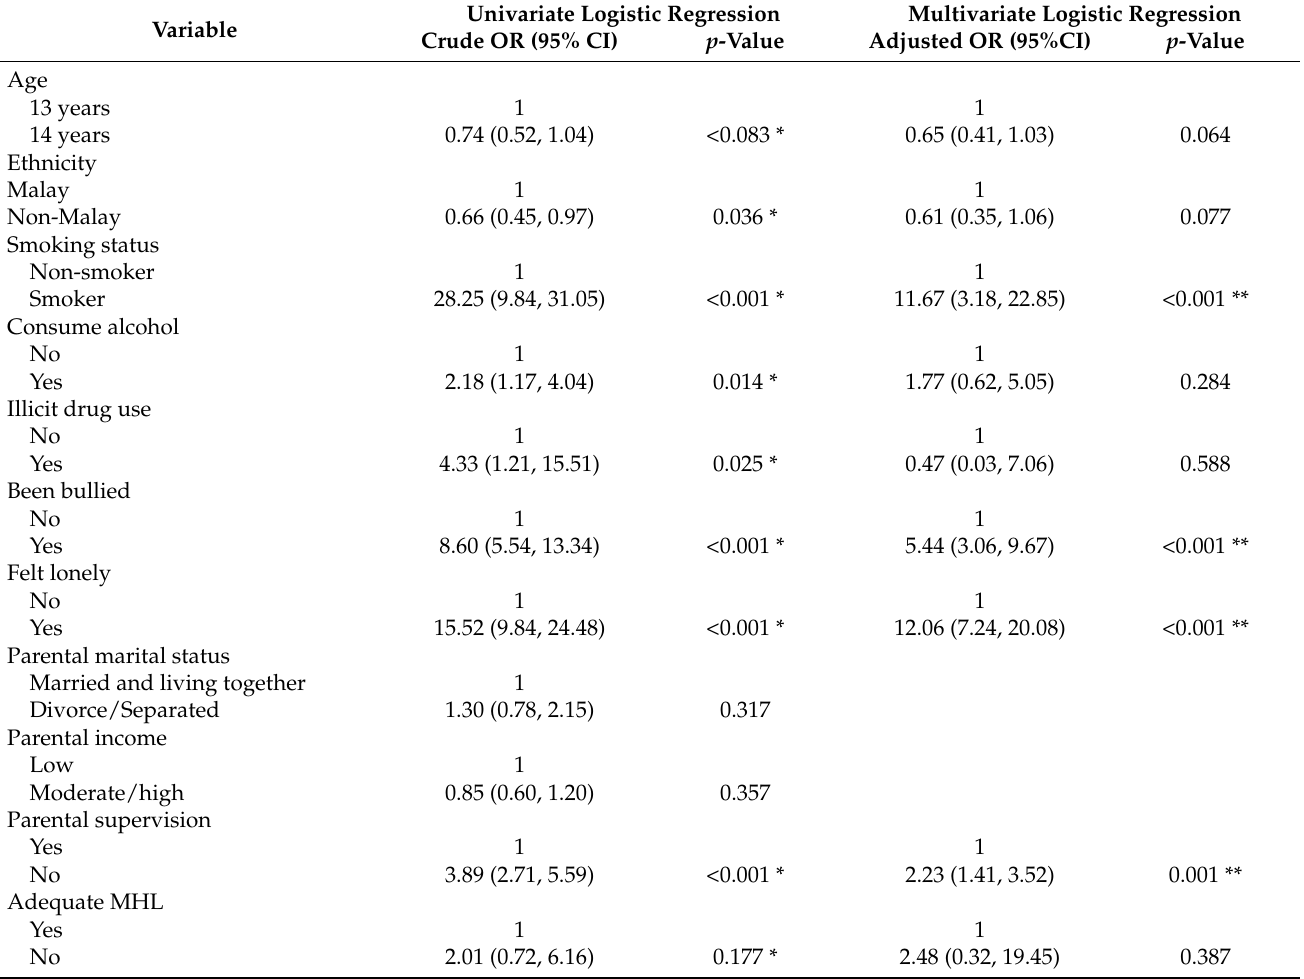
Table 3. Factors associated with depressive symptoms among females ( n =